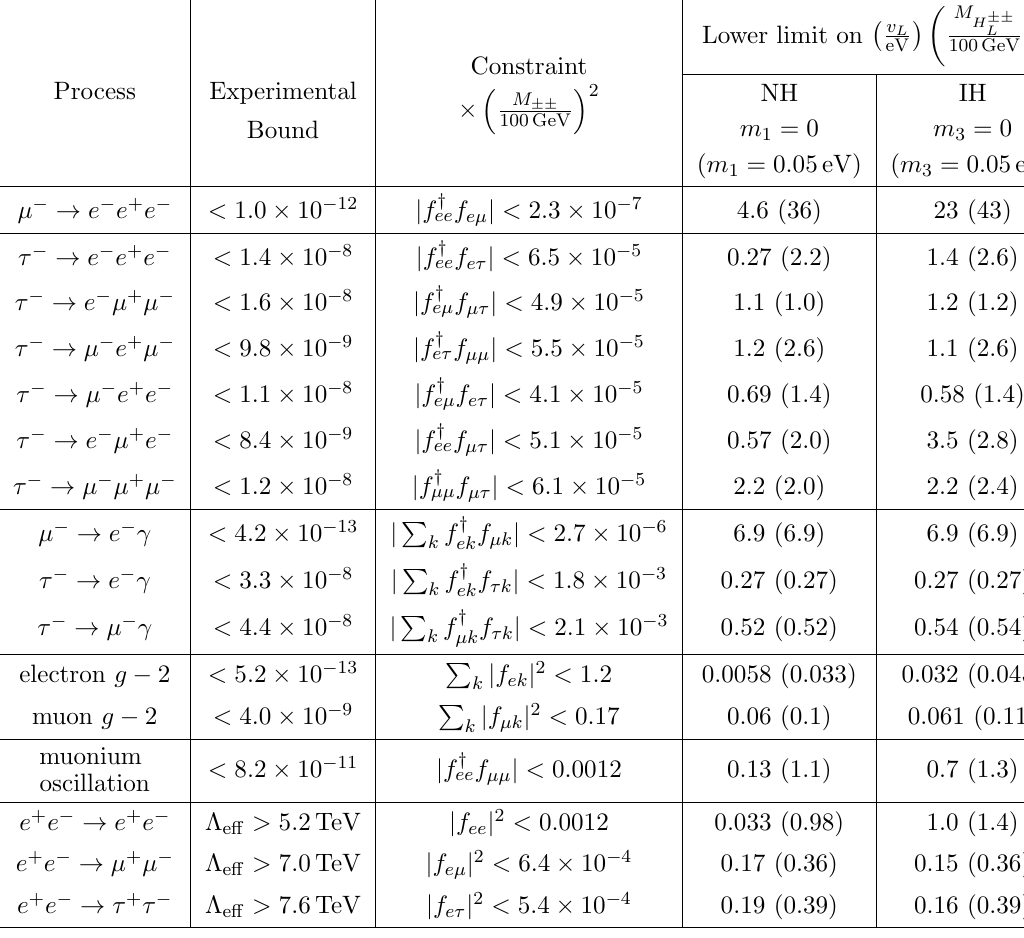
Table 2 . Current experimental limits on the BRs of ‘ (cid:11) ! ‘ (cid:12) ‘ (cid:13) ‘ (cid:14) , ‘ (cid:11) ! ‘ (cid:12) (cid:13) [70, 87], anomalous electron [88] and muon [89] magnetic moments, muonium oscillation [90], and LEP e + e (cid:0) ! ‘ + ‘ (cid:0) data [84], along with the corresponding constraints on the Yukawa couplings j f j or j f y f j , in unit of ( M (cid:6)(cid:6) = 100 GeV) 2 (third column). These limits apply to both H (cid:6)(cid:6)